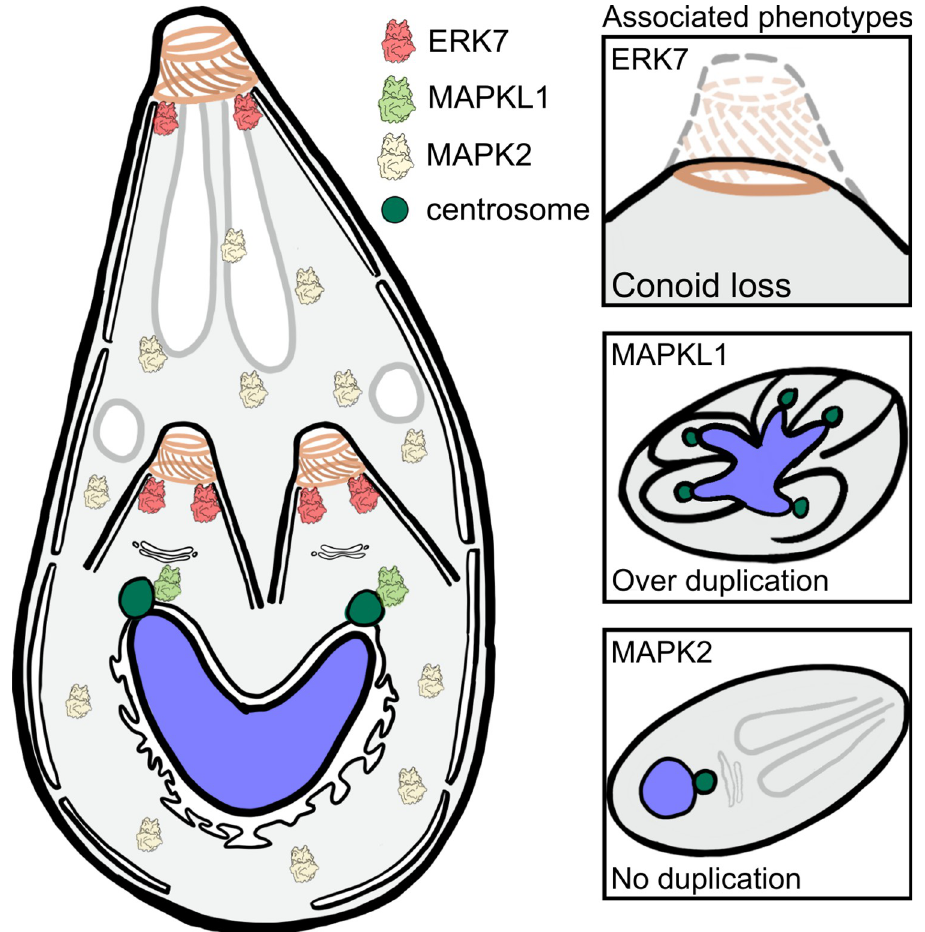
Fig 4. MAPK function in Toxoplasma tachyzoite replication. ERK7 (red kinase) localizes to the maternal and daughter bud apical caps, just below the conoid (orange rings). MAPKL1 (green kinase) localizes to the pericentrosomal material surrounding the centrosome (green circle). MAPK2 (yellow kinase) is cytosolic. Right panels show phenotypes resulting from knockdown of each of MAPKs. Loss of ERK7 results in destruction of the conoid. Loss of MAPKL1 and MAPK2 has opposing effects on centrosome duplication. MAPK, mitogen-activated protein kinase.